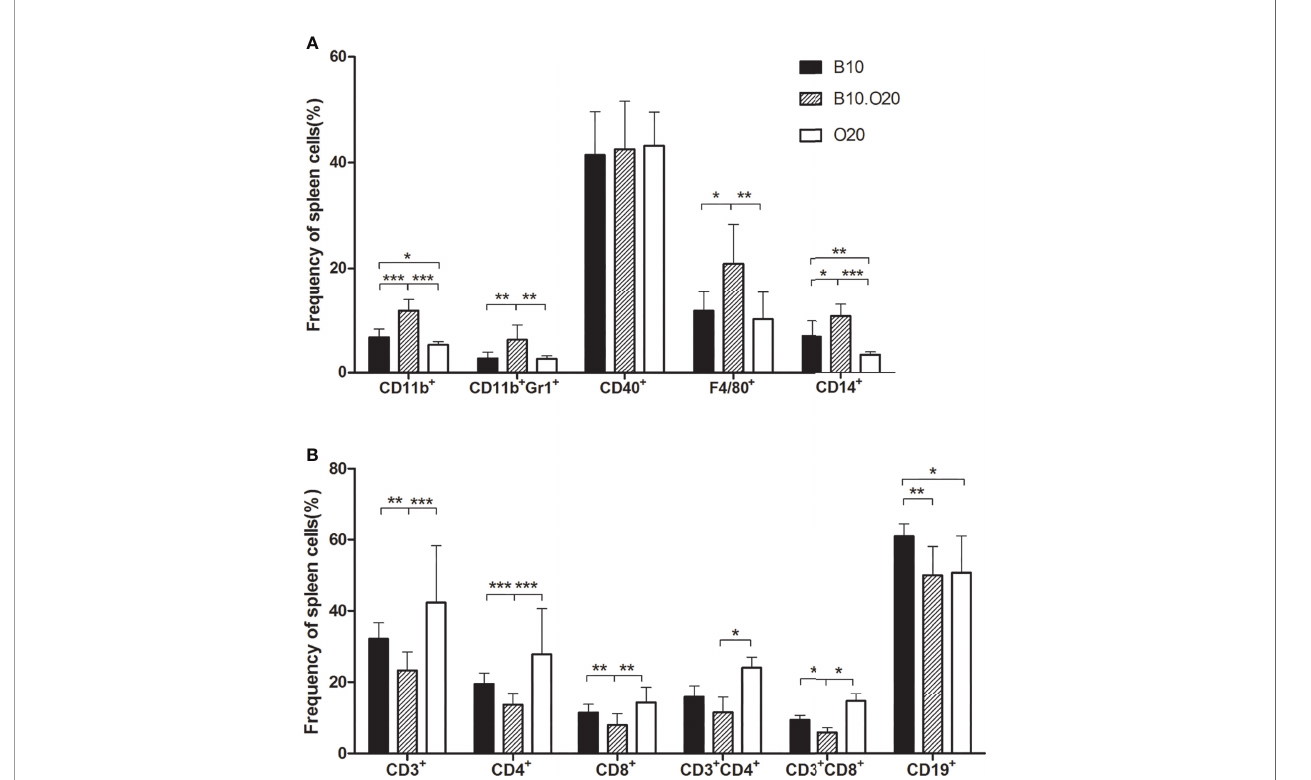
FIGURE 1 | White blood cell subsets in spleens of strain B10.O20 and the parental strains C57BL/10 (B10) and O20. (A) The proportion of CD11b + , CD11b + Gr1 + , CD40 + , F4/80 + , and CD14 + myeloid cell subsets. (B) The proportion of CD3 + , CD4 + , CD8 + , CD3 + CD4 + , and CD3 + CD8 + T-cell lineages, and CD19 + B-cell lineages. Values represent the average levels of samples tested in triplicates +SEM. Strains B10 (n = 9), B10.O20 ( n = 11), and O20 ( n = 10) are represented by black, striped, or white bars respectively. * p < 0.05; ** p < 0.01; *** p < 0.001 (analyzed by Mann – Whitney